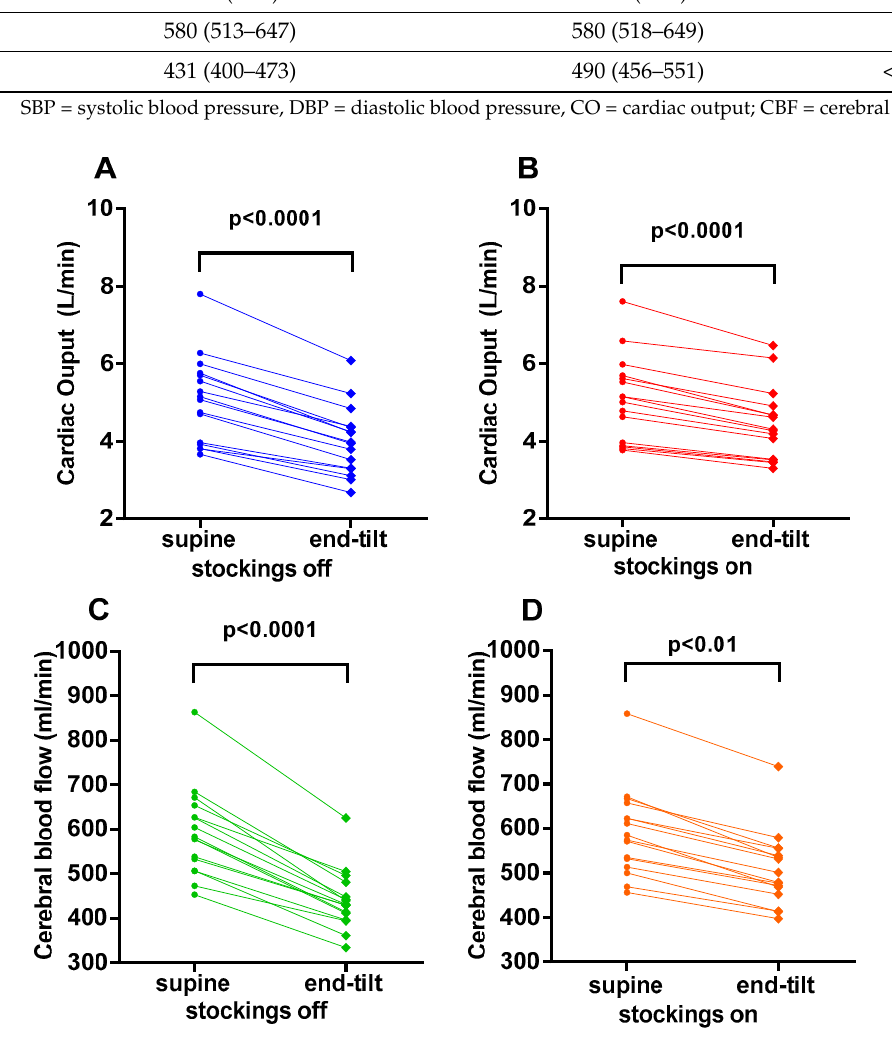
Table 1. Hemodynamic baseline characteristics.